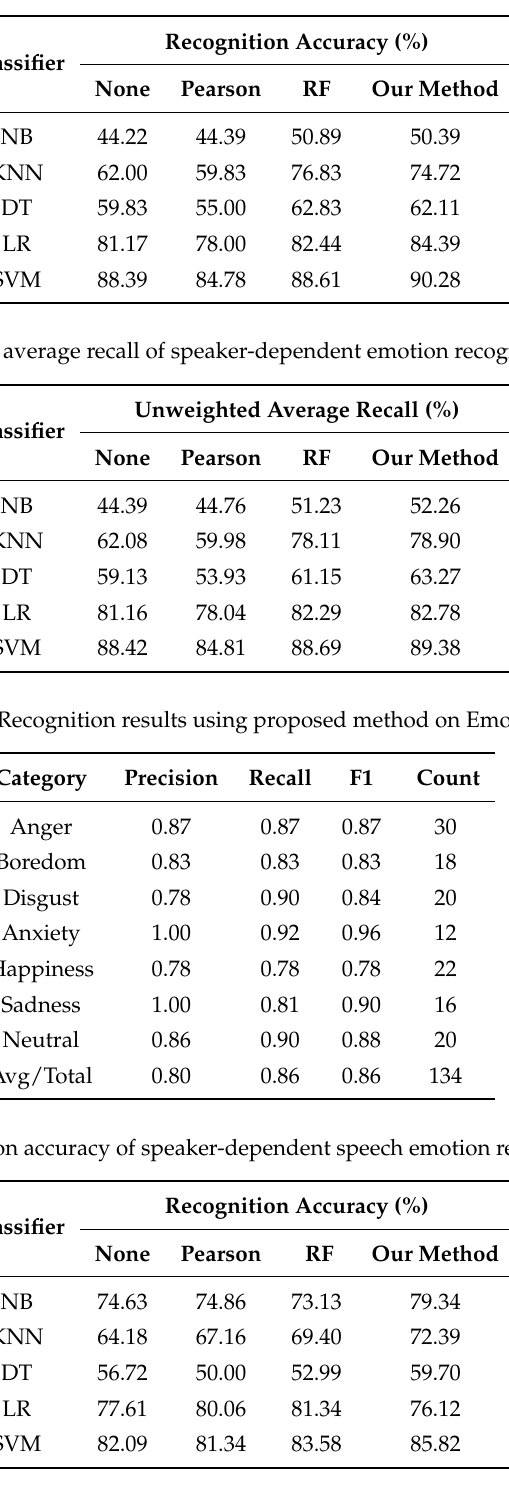
Table 5. Average recognition accuracy of speaker-dependent emotion recognition on CASIA.